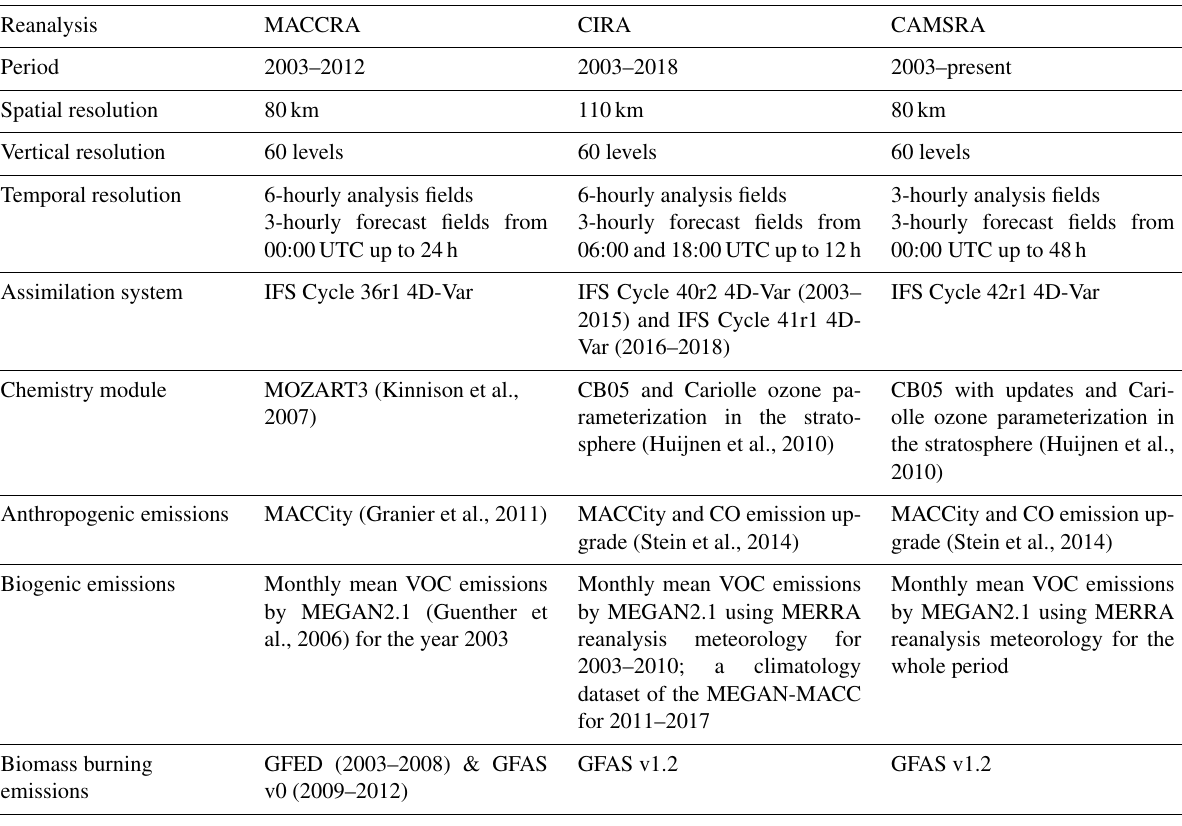
Table 1. Key setups of the three reanalyses.